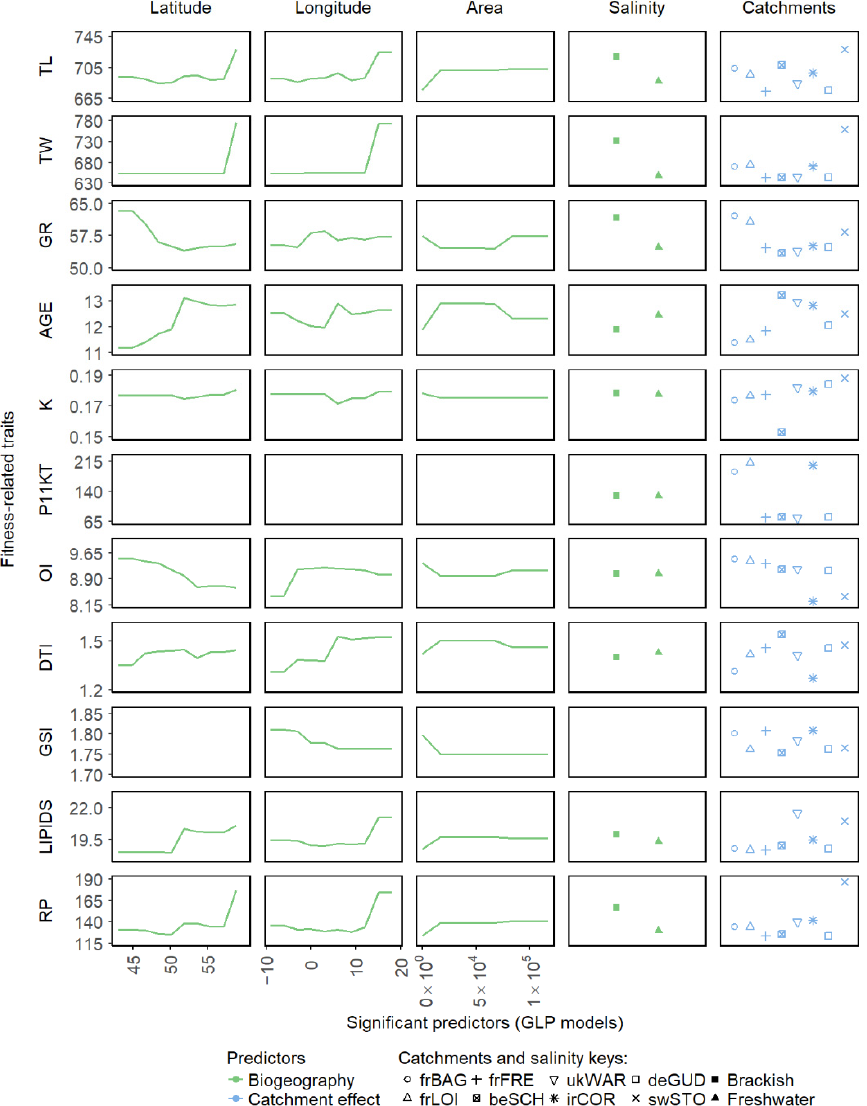
Figure 3. Marginal effect of geographic and local predictors (GLP models) on silver eel traits. Related to Figure 4. Plots show the partial dependence of significant GLP predictors after permutation test ( n = 75 silver eels, 62 for P11KT trait). TL: total length at silvering (mm), TW: total weight (g), GR: growth rate (mm · year − 1 ), AGE: estimated age (year), K: Fulton condition index (%), P11KT: plasma 11-ketotestoterone (pg · mL − 1 ), OI: Pankhurst’s ocular index (no unit), DTI: digestive tract index (%), GSI: gonado-somatic index (%), LIPIDS: muscular lipid content (%), RP: reproductive potential index (g of eggs). Empty cells correspond to non-significant